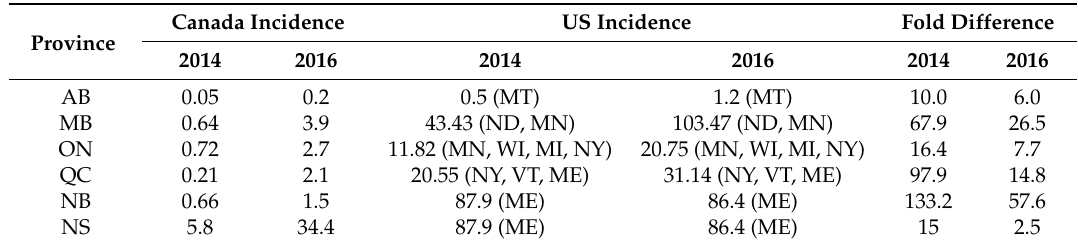
Table 1. Comparison between the reported incidence (per 100,000) of Lyme disease in Canadian provinces and the nearest American